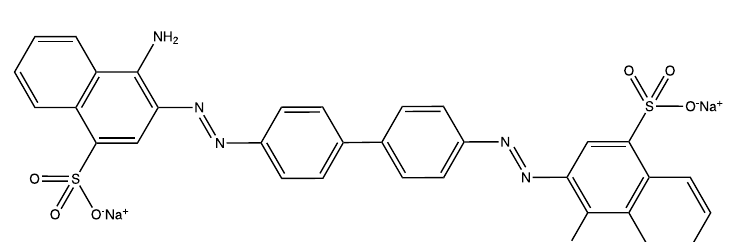
Fig. 1 Chemical structure of Congo